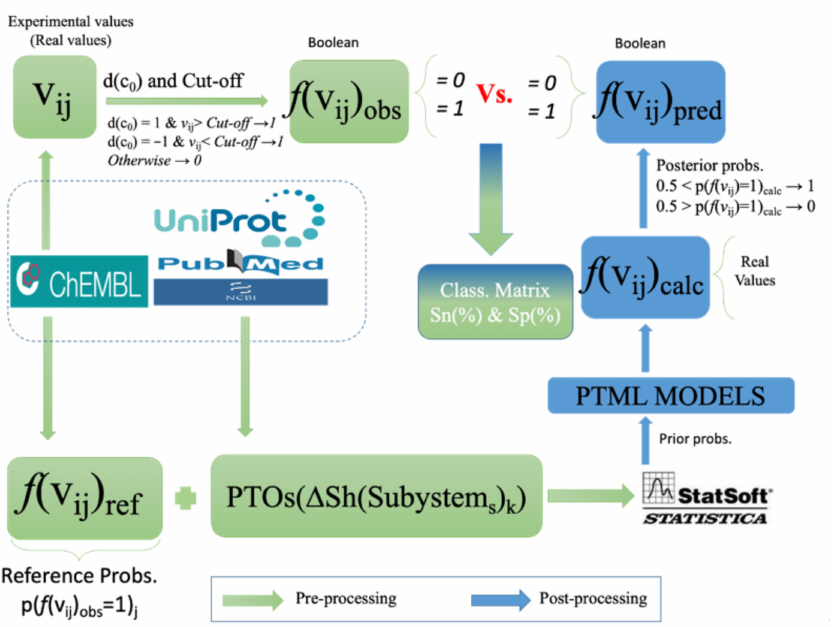
Figure 2. Variables pre-processing vs.